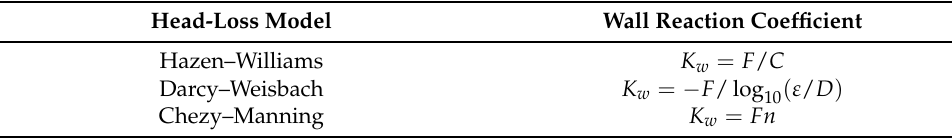
Table 2. Wall reaction formulas related to